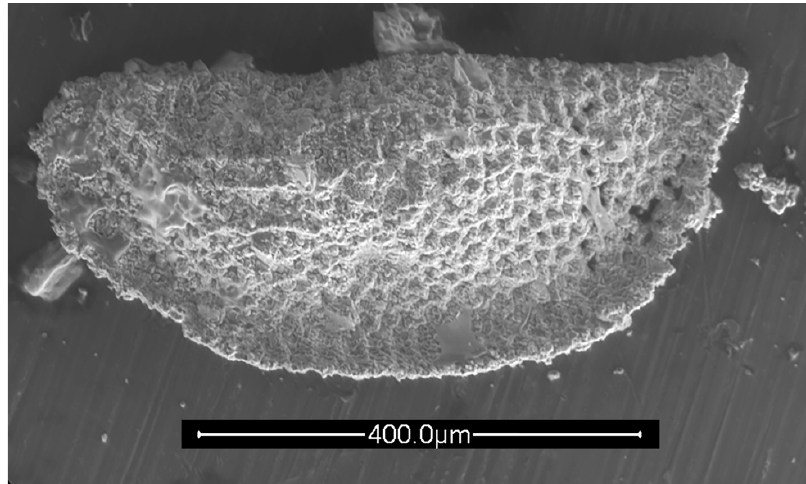
Figure 4. Kirkbya panamintensis nov. sp., left valve, lateral view. IGM 5011(2). Scanning electron micrograph (secondary electrons). Field sample MM-81-15; 29 m above the base of the Tin Mountain Limestone. Scale bar = 400 microns.